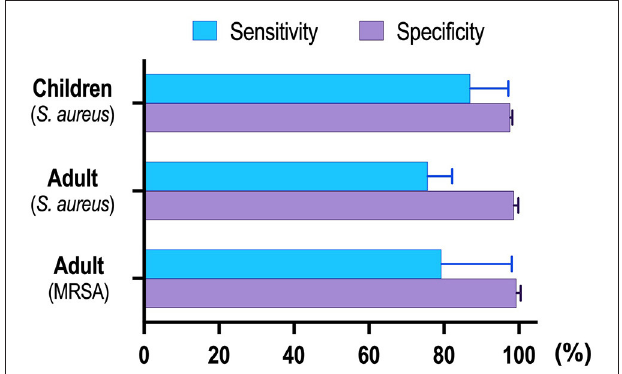
FIGURE 6 | Summary for NAAT’s pooled sensitivity and